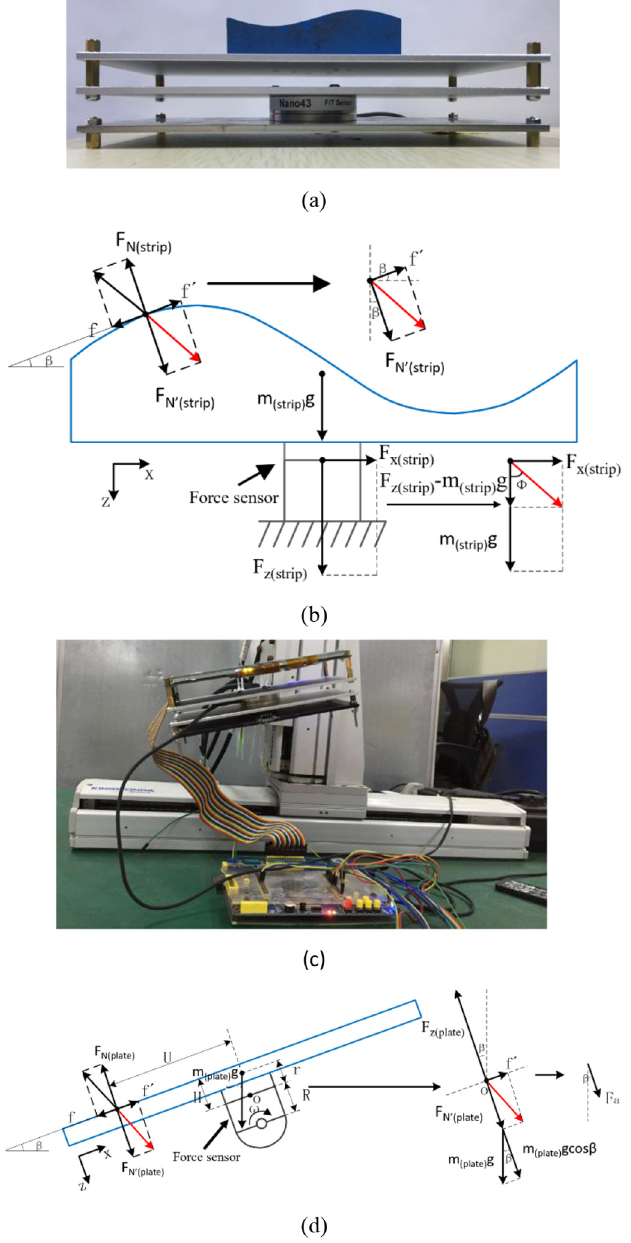
Fig. 11. Force measurement. (a) on physical strip; (b) illustra- tion of the force on strip; (c) on tactile display; (d) illustration of the force on tactile